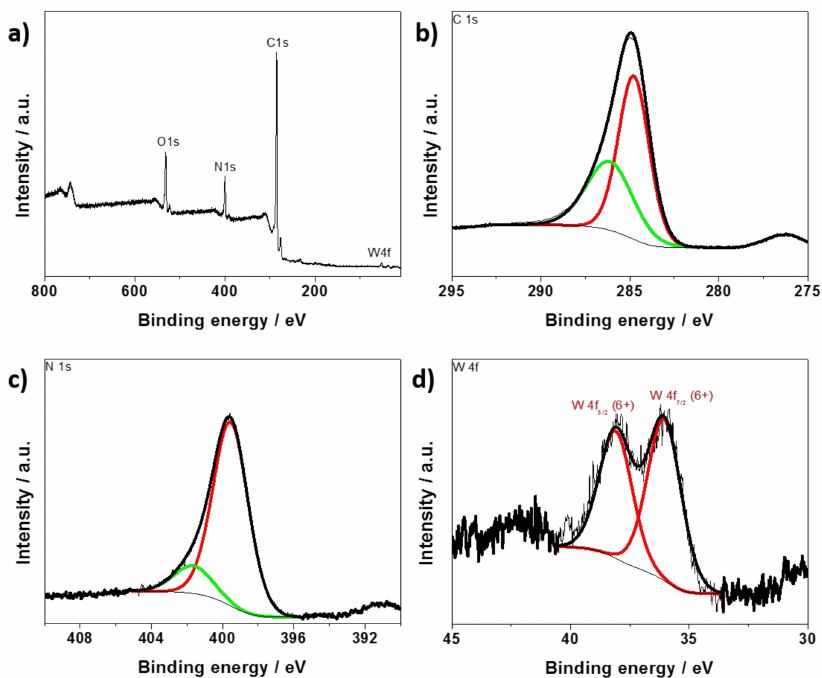
Figure 3. ( a ) XPS wide-scan spectrum of FTO/PANI/WO 3 ; high-resolution XPS spectra recorded for ( b ) C1s, ( c ) N1s and ( d ) W4f region.